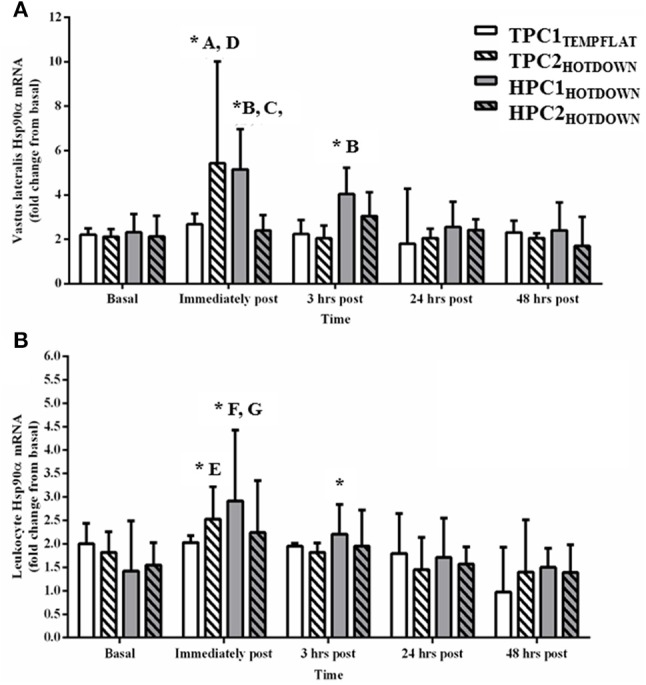
Hsp90α mRNA response immediately before, immediately post, 3 h post, 24 h post, and 48 h post exercise in the Vastus lateralis (A) and Leukocytes (B). * Increased (p < 0.02) compared to basal. A, increased (p = 0.006) during TPC2HOTDOWN compared to TPC1TEMPFLAT. B, increased (p < 0.001) during HPC1HOTDOWN compared to HPC2HOTDOWN. C, increased (p < 0.05) during HPC1HOTDOWN compared to TPC1TEMPFLAT. D, increased (p = 0.01) during TPC2HOTDOWN compared to HPC2HOTDOWN. E, (p = 0.024) during TPC2HOTDOWN compared to TPC1TEMPFLAT. F, increased (p = 0.030) during HPC1HOTDOWN compared to HPC2HOTDOWN. G, (p = 0.002) during HPC1HOTDOWN compared to TPC1TEMPFLAT. Data presented as median ± interquartile range.